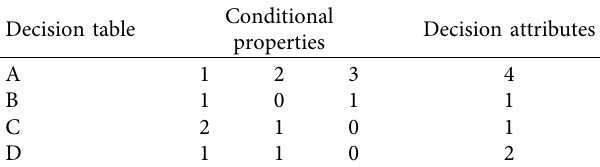
Table 4: Rough set decision-making.